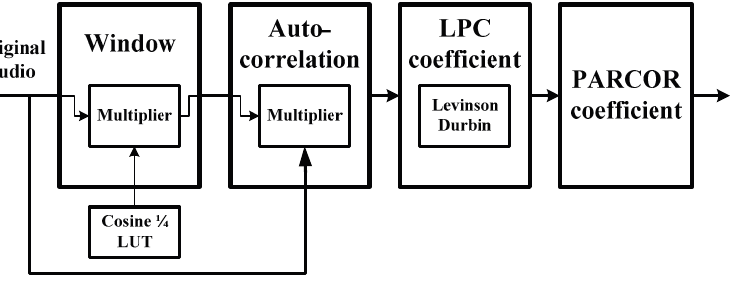
Figure 6. Flow of predictor coefficient calculation.